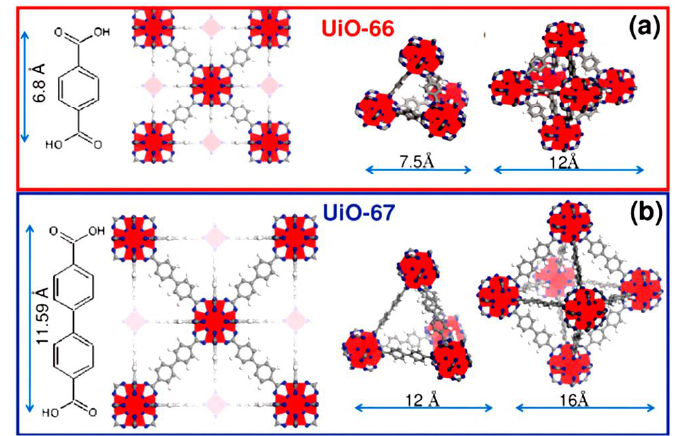
Figure 3. Structures of UiO-66 ( a ) and UiO-67 ( b ). Reprinted with permission from reference [34]. Copyright 2017 Royal Society of Chemistry.